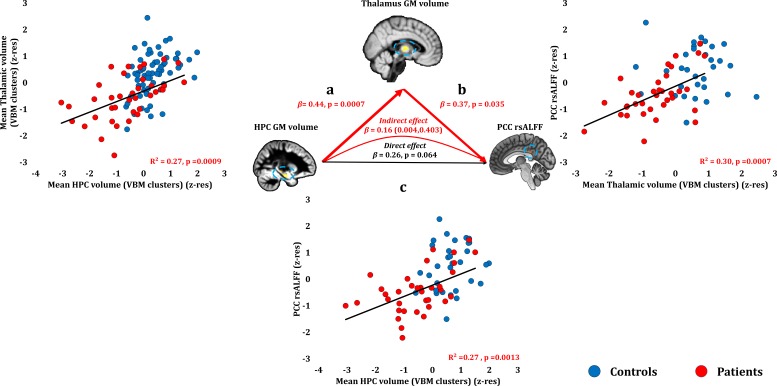
Relationship of HPC atrophy with PCC functional abnormalities.Given the reciprocal connectivity of thalamic nuclei with both the HPC and the cingulate cortex (Aggleton, 2014; Aggleton et al., 2010; Bubb et al., 2017) and our hypothesis that HPC atrophy is followed by structural and functional abnormalities in interconnected areas within the HPC-diencephalic-cingulate networks, we assumed a causal chain of events, whereby HPC damage has remote effects on thalamic volume, which, in turn, lead to abnormalities in the cingulate cortex, observed here in the form of reduced rsALFF in the PCC. We used a series of bivariate correlations and mediation analyses, with HPC volume as the independent variable, thalamic volume as the mediator variable, and rsALFF in the PCC as the dependent variable. A mediation analysis supported this hypothesis, showing that the effects of the average GM volume reduction in the HPC VBM clusters on patients’ reduced rsALFF in the PCC were fully mediated by the correlative reduction of the average GM volume of the thalamic VBM clusters (direct effect: β = 0.26, p=0.064; indirect effect: β = 0.16, 95% CI: 0.004,0.403); a: mean GM volume of the two HPC clusters correlated with the mean GM volume of the two thalamic clusters across patients; b: mean PCC rsALFF correlated across patients with the mean GM volume of the two thalamic clusters; the mediation analysis demonstrates that this effect held when the correlation of thalamic GM volume with the mean GM volume of the HPC clusters was accounted for; c: mean GM volume of the HPC clusters correlated with PCC rsALFF; the mediation analysis demonstrated that this relationship did not hold over and above the correlation of the mean GM volume of the thalamic clusters with the HPC clusters; there was thus no direct effect of reduced HPC GM volume on PCC rsALFF (within parenthesis: 95% confidence intervals); GM: gray matter; HPC: hippocampus; MAP: Memory and Amnesia Project; OPTIMA: Oxford Project To Investigate Memory and Aging; PCC: posterior cingulate cortex; rsALFF: resting-state amplitude of low frequency fluctuations; TIV: total intracranial volume; VBM: voxel-based morphometry; z-res: GM volumes from VBM clusters are residualized against age, sex, scan source (MAP, OPTIMA), and TIV across participants; mean rsALFF is residualized against age and sex across participants.10.7554/eLife.46156.007Figure 2—figure supplement 1—source data 1.This spreadsheet contains the mean GM volume of the HPC and thalamic VBM clusters and the mean rsALFF in the PCC cluster (z-res) for healthy controls and patients that are plotted in Figure 2—figure supplement 1; GM: gray matter; HPC: hippocampus; MAP: Memory and Amnesia Project; OPTIMA: Oxford Project To Investigate Memory and Aging; PCC: posterior cingulate cortex; rsALFF: resting-state amplitude of low frequency fluctuations; TIV: total intracranial volume; VBM: voxel-based morphometry; z-res: GM volumes from VBM clusters are residualized against age, sex, scan source (MAP, OPTIMA), and TIV across participants; mean rsALFF is residualized against age and sex across participants.These data can be opened with Microsoft Excel or with open-source alternatives such as OpenOffice.